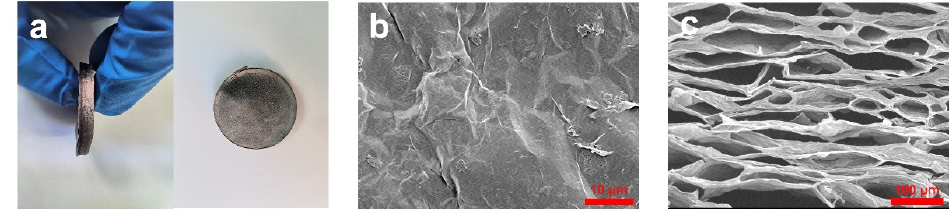
Figure 4. ( a ) Photograph of GA, ( b ) planar SEM image, and ( c ) cross-sectional image of GA.